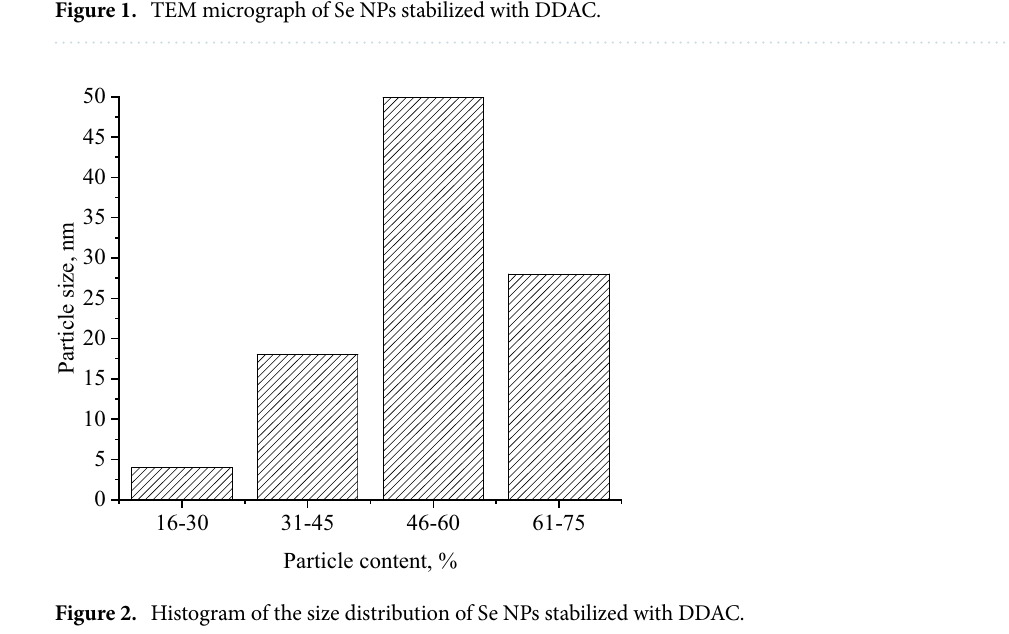
Figure 1. TEM micrograph of Se NPs stabilized with DDAC.